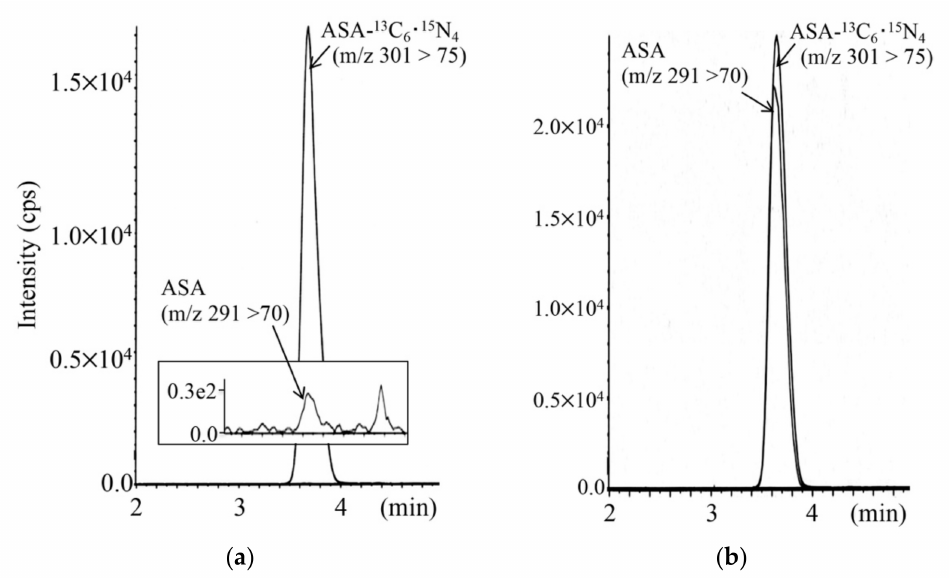
Figure 7. LC-MS/MS analysis for argininosuccinic acid (ASA) using positive ion mode for a control newborn ( a ) and a newborn with argininesuccinate lyase deficiency ( b ). The gradient elution program was as follows: 0% B (1 min), 0% to 30% B (4 min), 30% to 100% B (0.5 min), 100% B (5.5 min), 100% to 10% B (0.5 min), and 10% B (5 min).